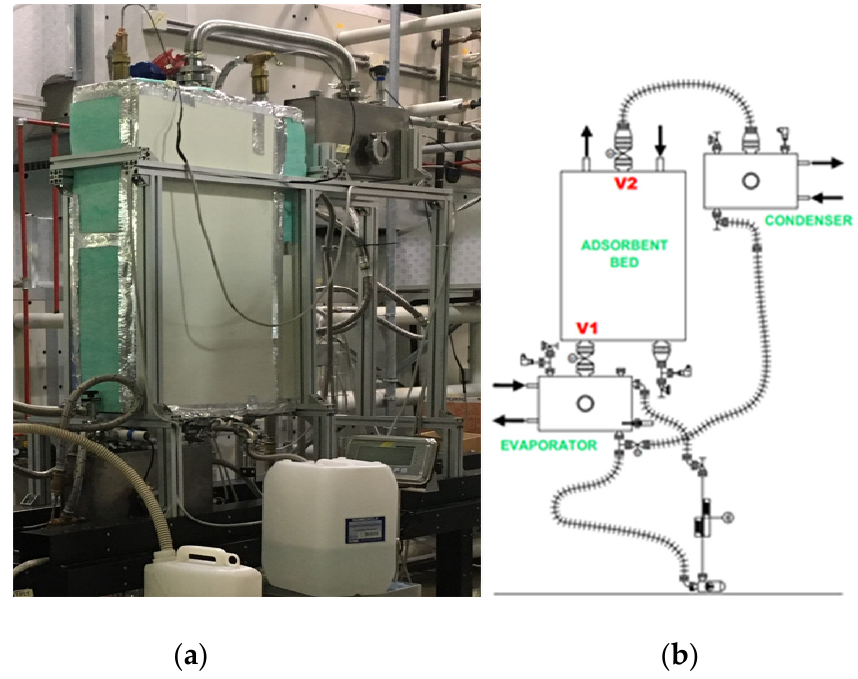
Figure 1. Photo ( a ) and functional scheme ( b ) of the test rig.